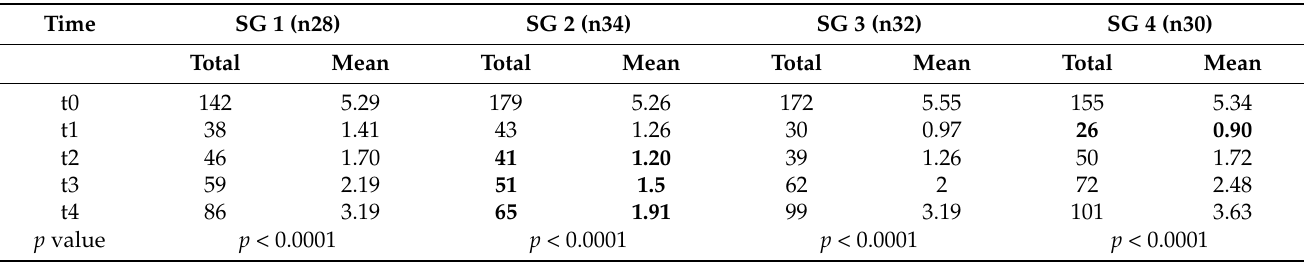
Table 1. Total and mean values of discomfort scores (VAS) at baseline (t0), immediately after the treatment test (t1) and, after 1 week (t2), 1 month (t3) and 6 months (t4) for each study group. The values with greater pain control are highlighted in bold. Statistical correlation between VAS value at baseline vs. all VAS values at different times using the Wilcoxon signed-rank test.